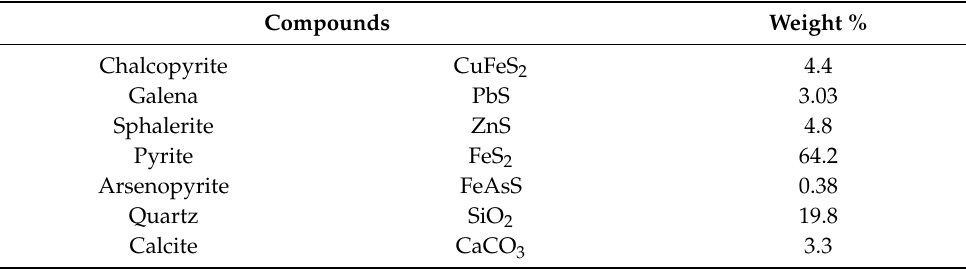
Table 3. Mineralogical reconstruction of the gold